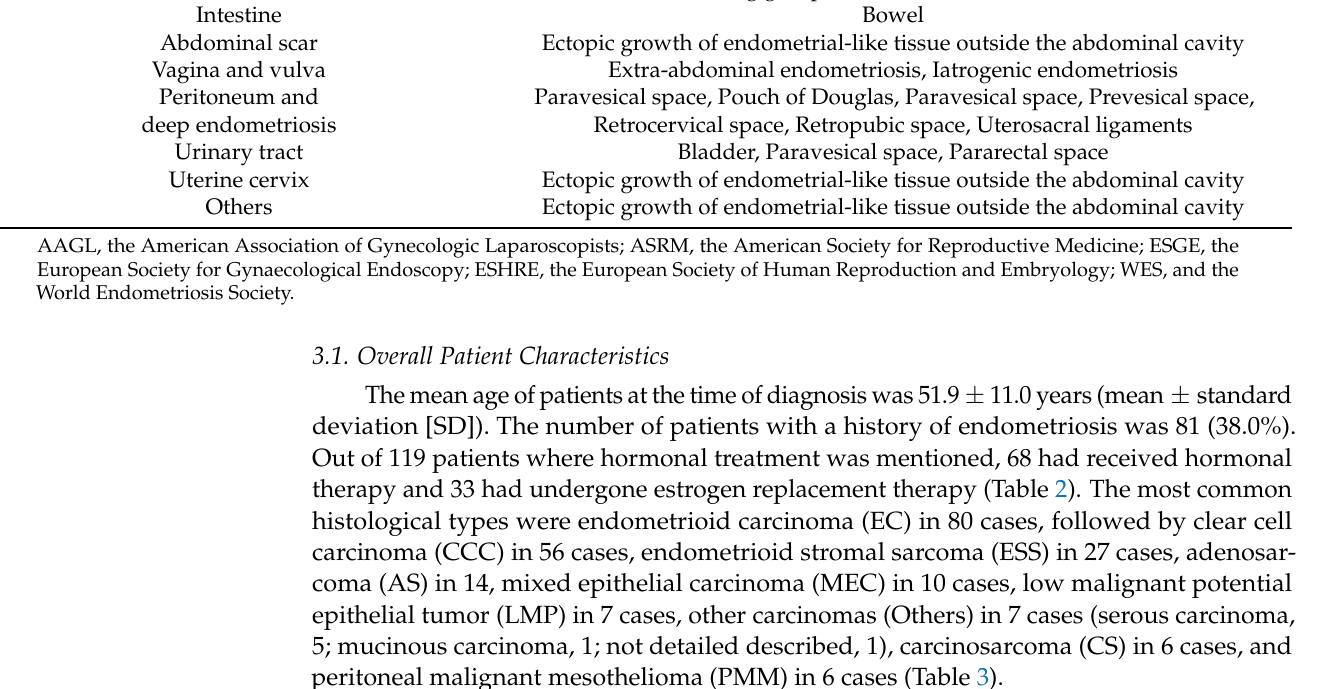
Table 1. Correspondence table of tumor site, from this review to newly proposed diagnosis by the international working group of AAGL, ASRM, ESGE, ESHRE and WES.